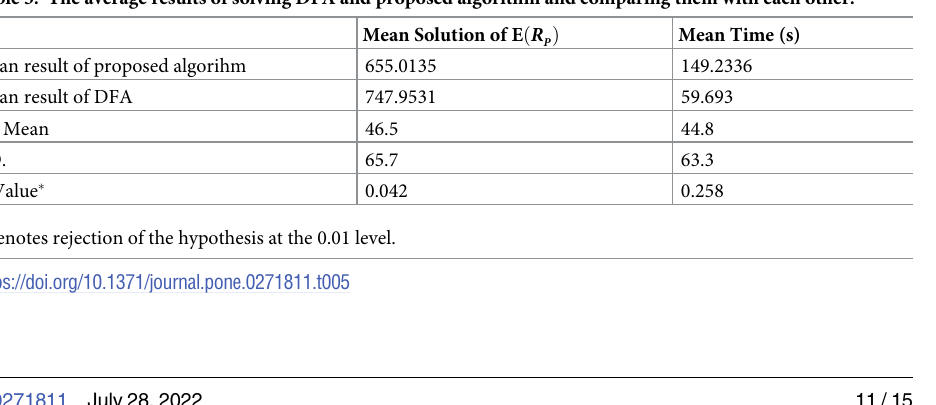
Table 5. The average results of solving DFA and proposed algorithm and comparing them with each